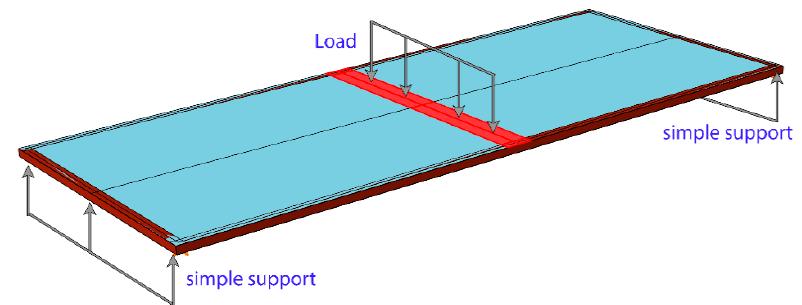
Figure 16. Boundary conditions and loading scheme during the rectangular panel validation test.